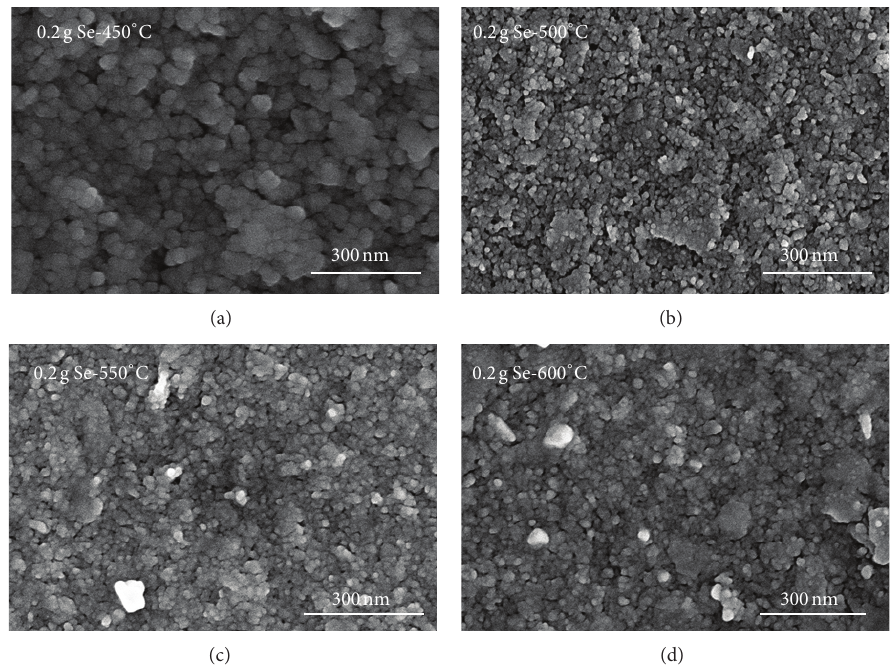
Figure 2: Surface morphologies of the CIS absorber layers as a function of selenization temperature the extra Se content was 0.2 g.